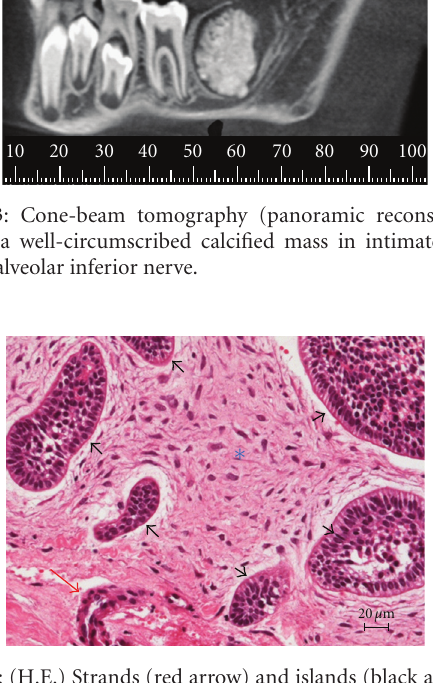
Figure 4: (H.E.) Strands (red arrow) and islands (black arrows) of odontogenic epithelium showing peripheral palisading and loosely arranged central cells, identical to stellate reticulum embedded in myxoid cell-rich stroma resembling the dental papilla ( ∗ ).